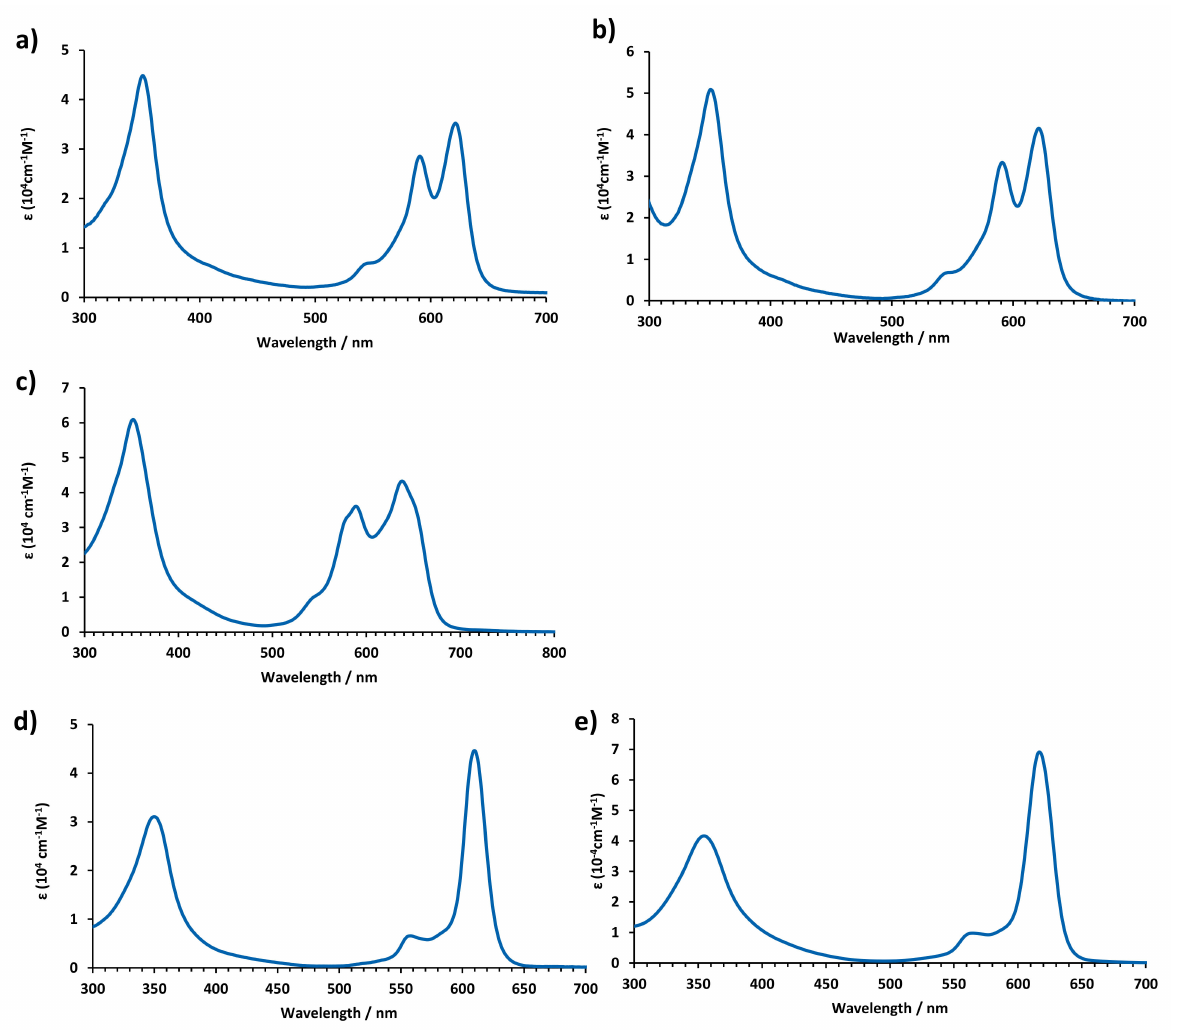
Figure 4. UV-Visible absorption spectra of Pzs ( a ) 6 , ( b ) 7 , ( c ) 11 , ( d ) 13 and ( e ) 14 in